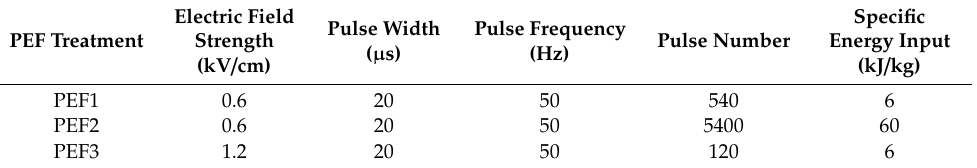
Table 1. Parameters of three di ff erent Pulsed electric fields (PEF)